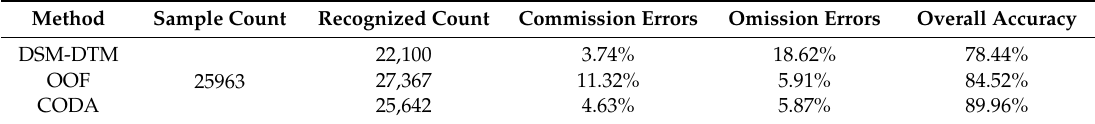
Table 5. Errors and accuracy of the results by OOF, DSM-DTM, and CODA (test in the GGA).